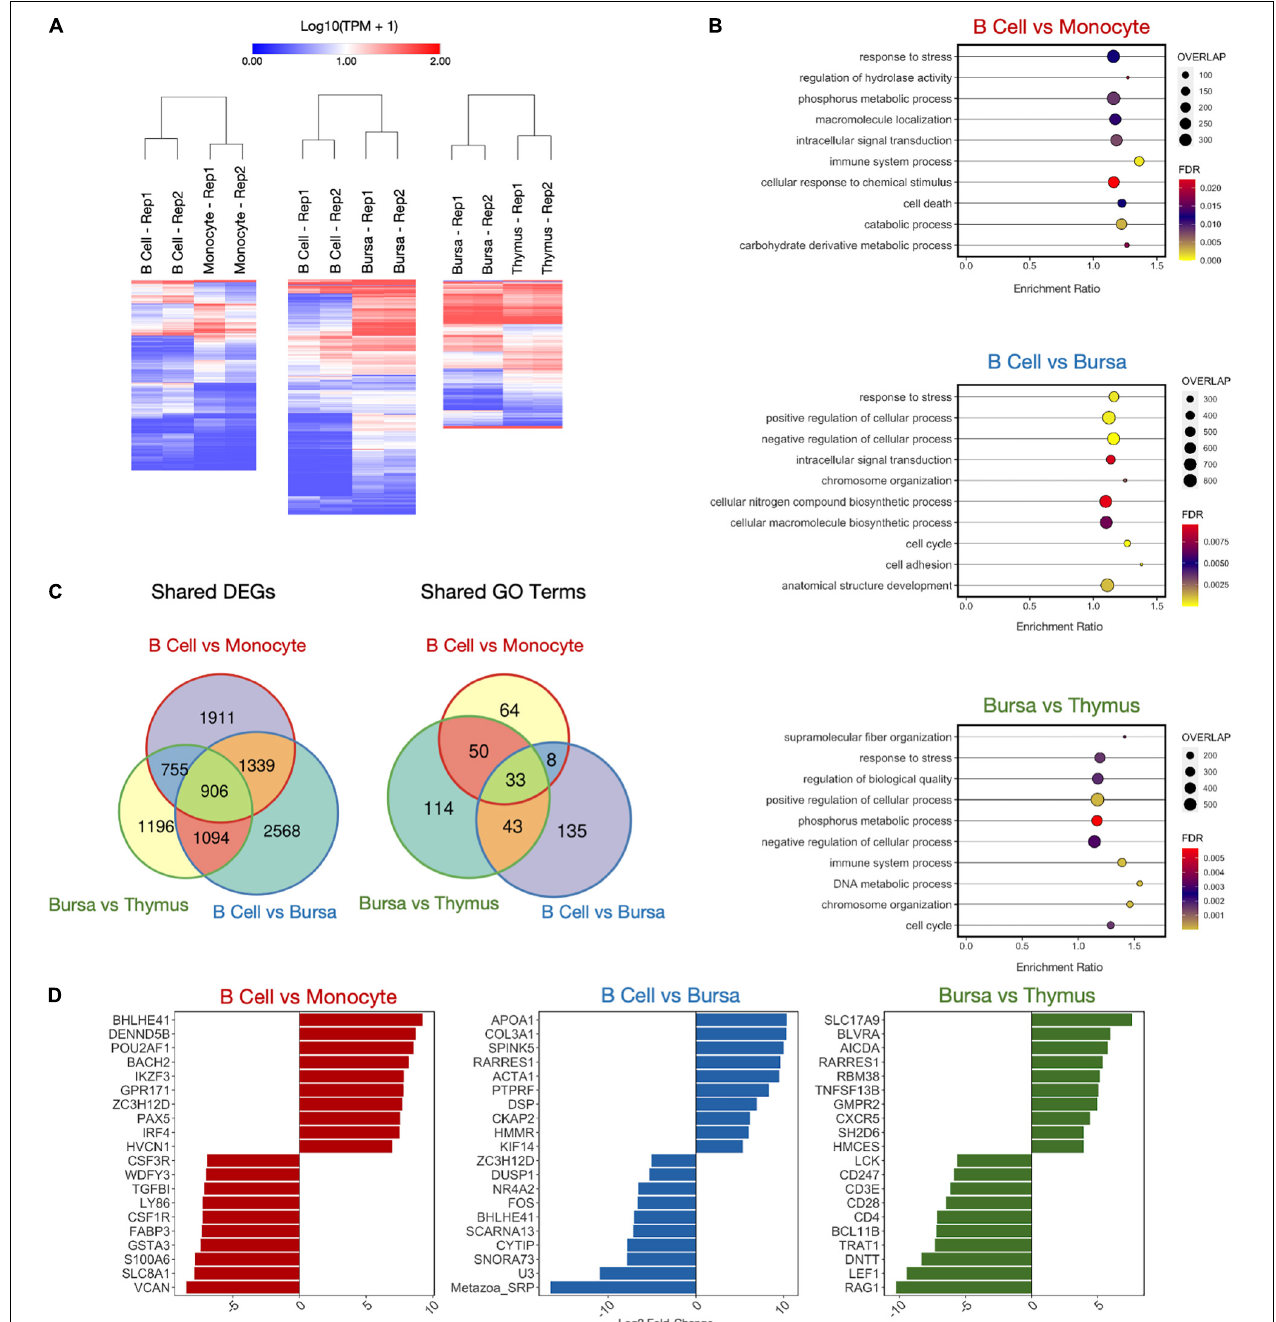
FIGURE 5 | Differentially expressed gene (DEG) analysis on immune samples. (A) Heatmaps of DEGs in three cell type comparisons: B cells vs. monocytes (4911 DEGs), B cells vs. bursa tissue (5907 DEGs), bursa tissue vs. thymus tissue (3951 DEGs). Samples were clustered both by column and by row using Euclidean distance based on log-transformed TPM value. (B) Enriched GO biological process categories for each sample using weighted set cover filtering in WebGestalt. “Overlap” quantifies the number of DEGs present in that GO set. (C) The numbers of DEGs overlapping between-sample comparisons. (D) Log 2 fold-change of top 10 upregulated and downregulated DEGs for each sample